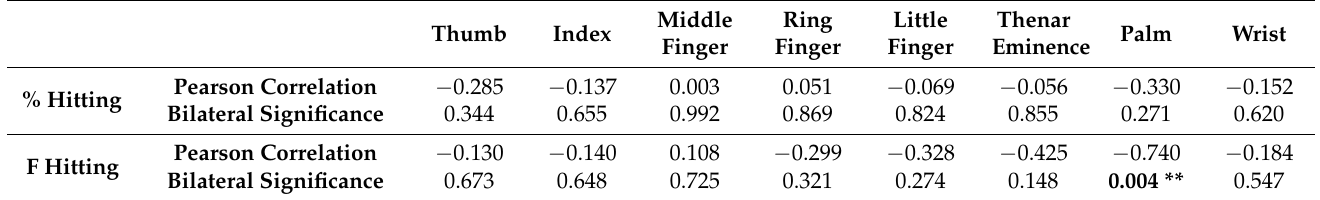
Table 3. Correlation between variation of skin temperature of the ROIs and dominant hand ball